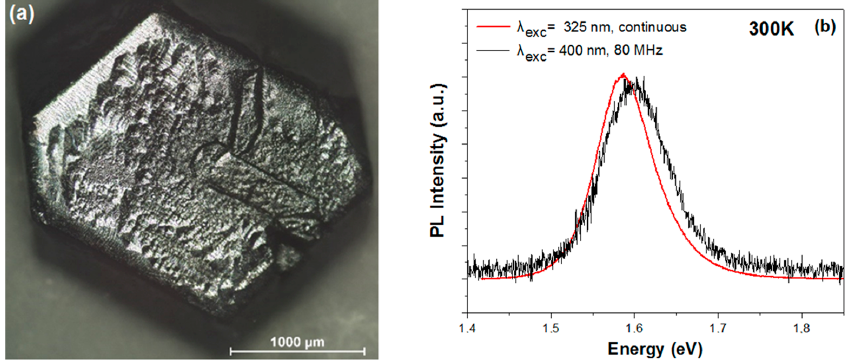
Figure 9. ( a ) Microscopy image of a millimeter sized MAPI crystal; ( b ) PL spectrum at room temperature of this MAPI crystal, taken six months after its growth, under continuous excitation at E exc = 3.815 eV ( λ exc = 325 nm, HeCd laser) (red line) and quasi-continuous excitation at E exc = 3.1 eV ( λ exc = 400 nm) with a 80 MHz doubled-frequency pulsed Ti-Sa laser (black line).